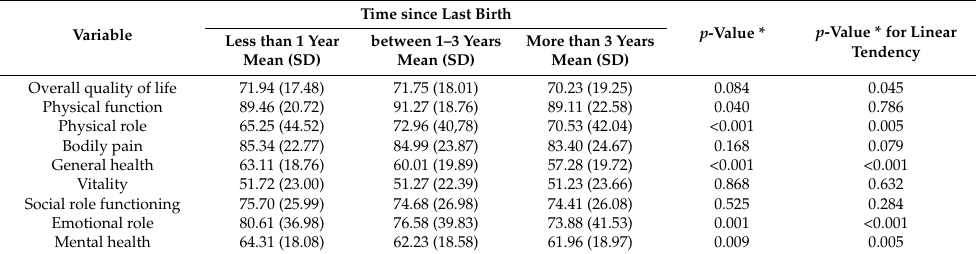
Table 2. Overall scores for quality of life and dimensions according to time points. Time since Last Variable